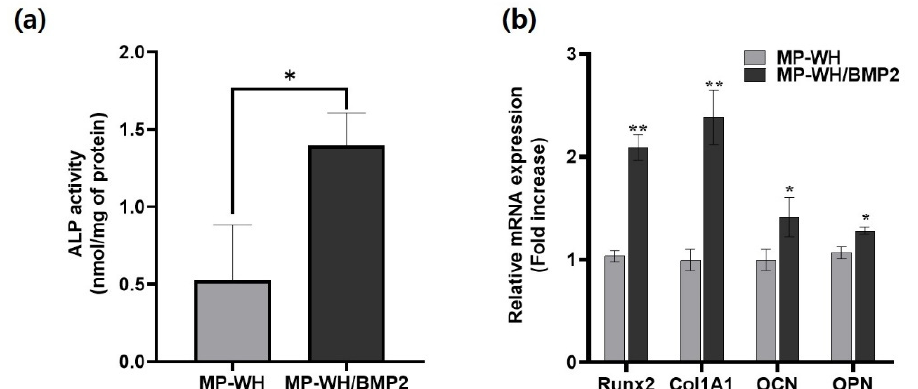
Figure 8. Effects of the BMP2 incorporation into MP-WH on osteoblast differentiation. hMSCs are cultured on MP-WH and MP-WH/BMP2 granules, and osteoblast differentiation are deter- mined by ( a ) the ALP activity assay and ( b ) RT-PCR for specific osteoblast marker genes. Data are means ± standard deviation (SD). * p < 0.05 and ** p < 0.01 indicate significant differences of MP-WH/BMP2 from MP-WH.